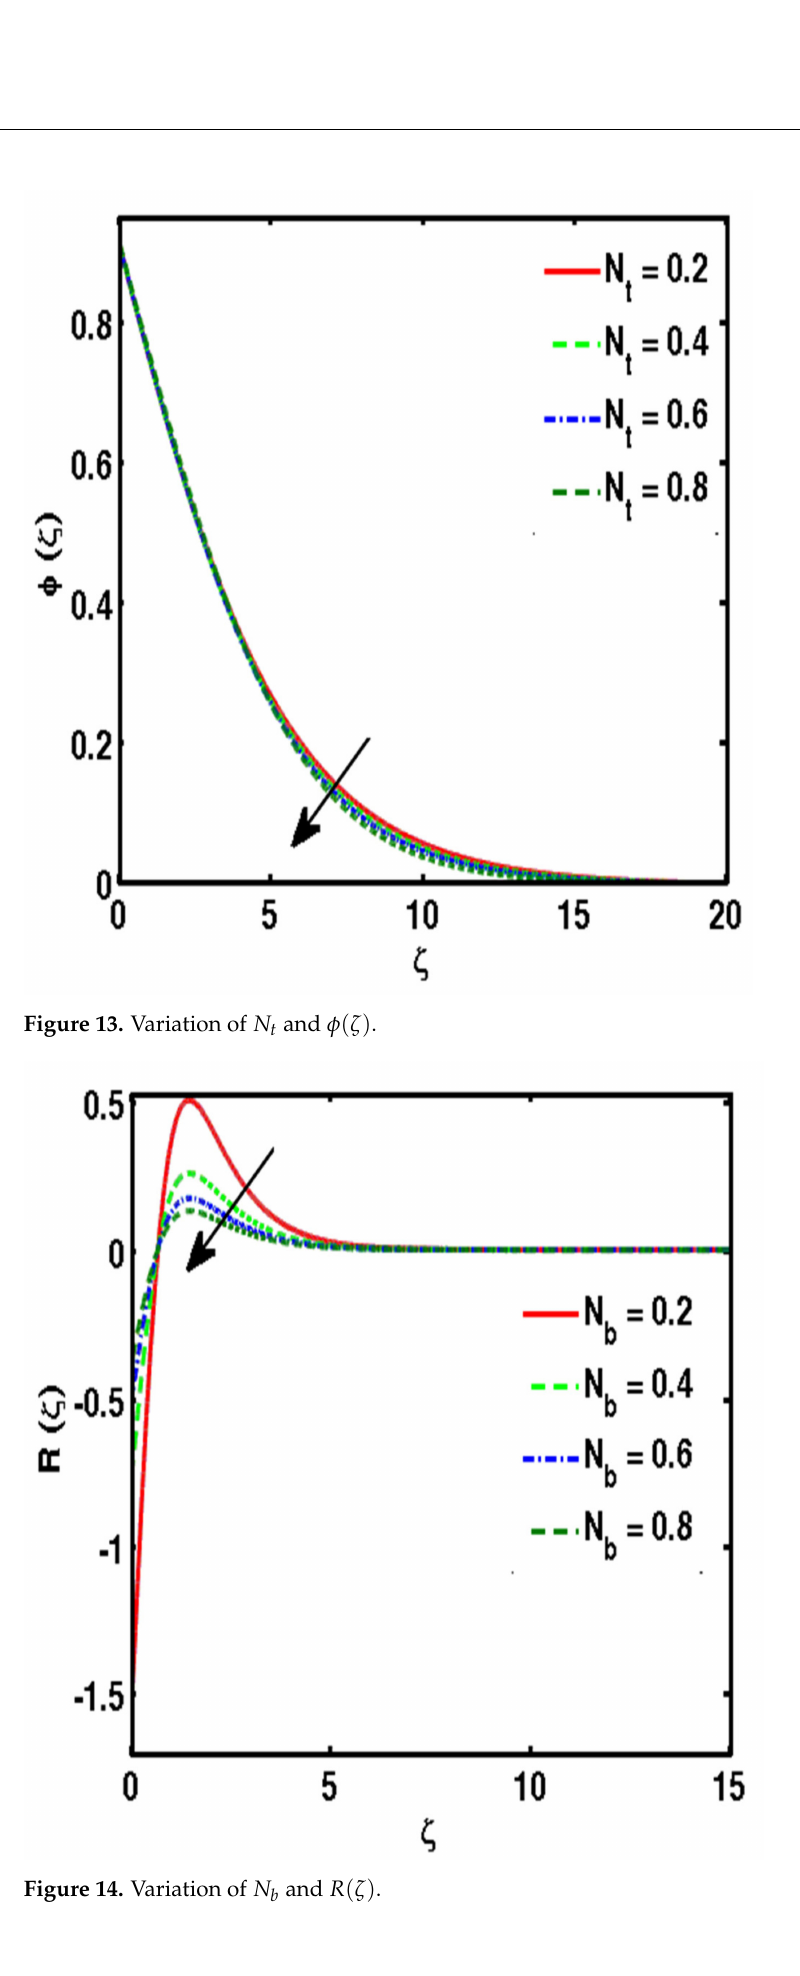
Figure 14. Variation of N b and R ( ζ )